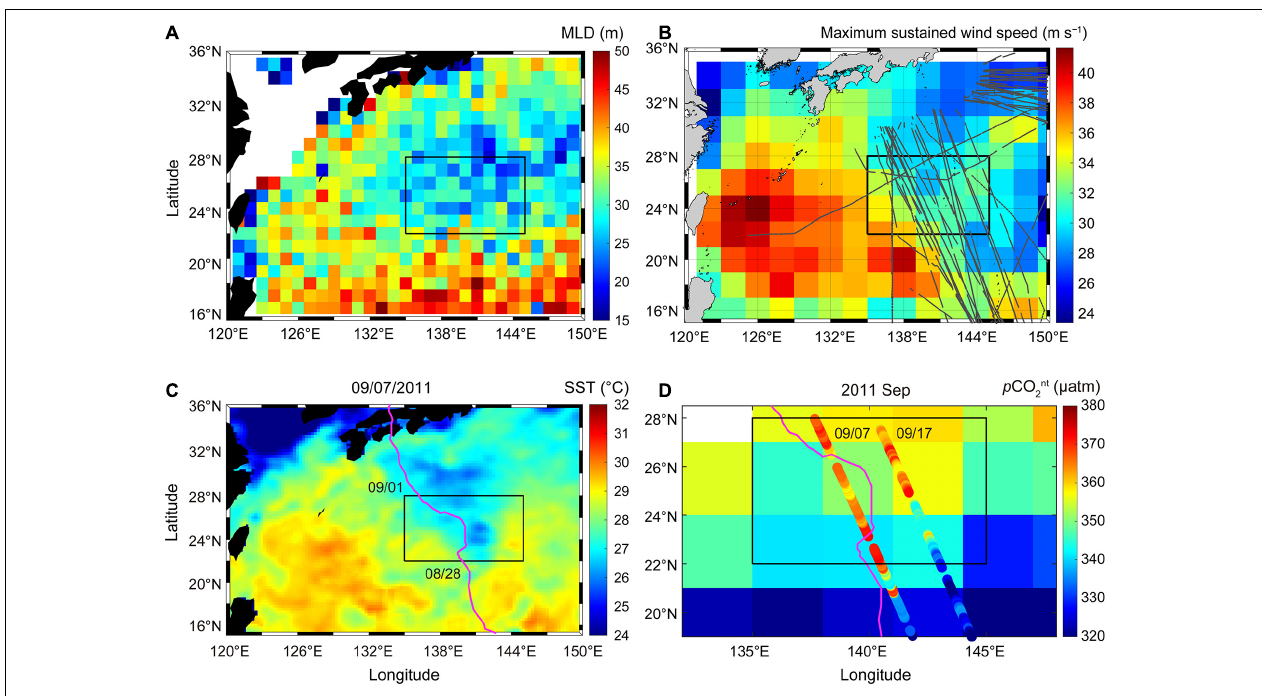
FIGURE 2 | (A) TC season (July–October) mean mixed layer depth (MLD; m) from a climatological MLD database derived from Argo profiles (Holte et al., 2017). (B) Mean values of the maximum sustained wind speed (2 ◦ × 2 ◦ gridded shading: m s − 1 ) of tropical cyclones (TCs) passing the given pixels and cruise tracks (gray lines) for p CO 2 measurements during summer (July–October) over the 11 study years (2007–2017). (C) A map of SST ( ◦ C) for September 7, 2011 in the western Pacific Ocean. The solid pink line represents the track of TC “Talas,” which passed over the study region (black solid rectangle) from August 31–September 1, 2011. (D) Climatological p CO 2 nt (2 ◦ × 2 ◦ gridded shading) and measured p CO 2 nt values (colored circles) in September 2011. The climatological p CO 2 nt values were calculated from climatological monthly p CO 2 values for September based on SOCAT v4 data (Fassbender et al., 2017). The solid pink line indicates the track of TC “Talas” (maximum sustained wind speed > 25 m s − 1 in the study